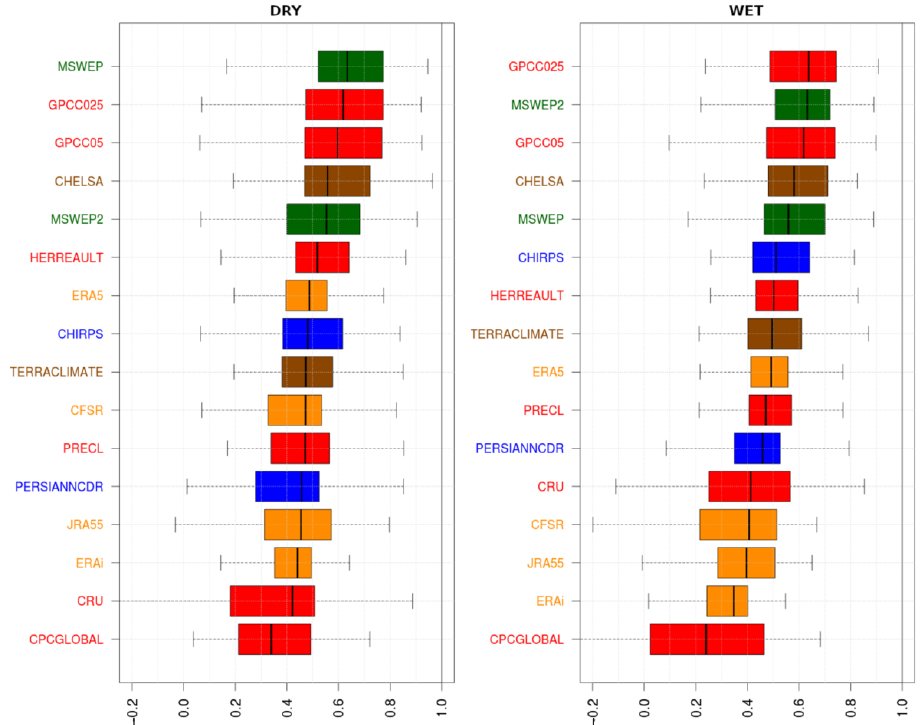
Figure 4. As in Figure 3 but just for KGE index for dry (left) and wet (right) seasons.